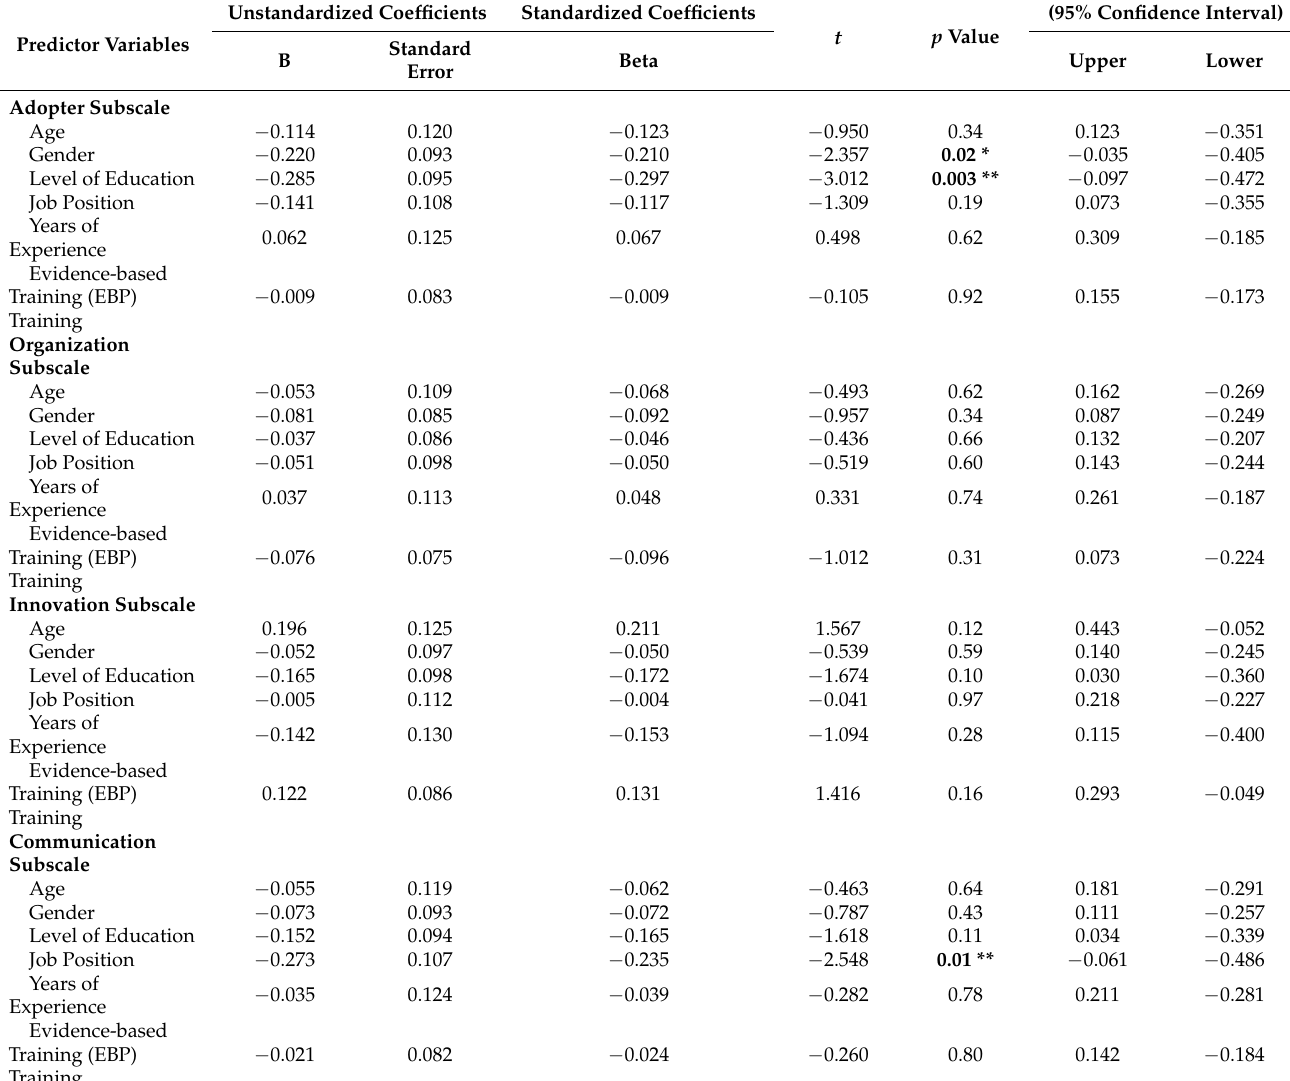
Table 3. Results of Regression Analysis on the BARRIERS Subscales ( n =